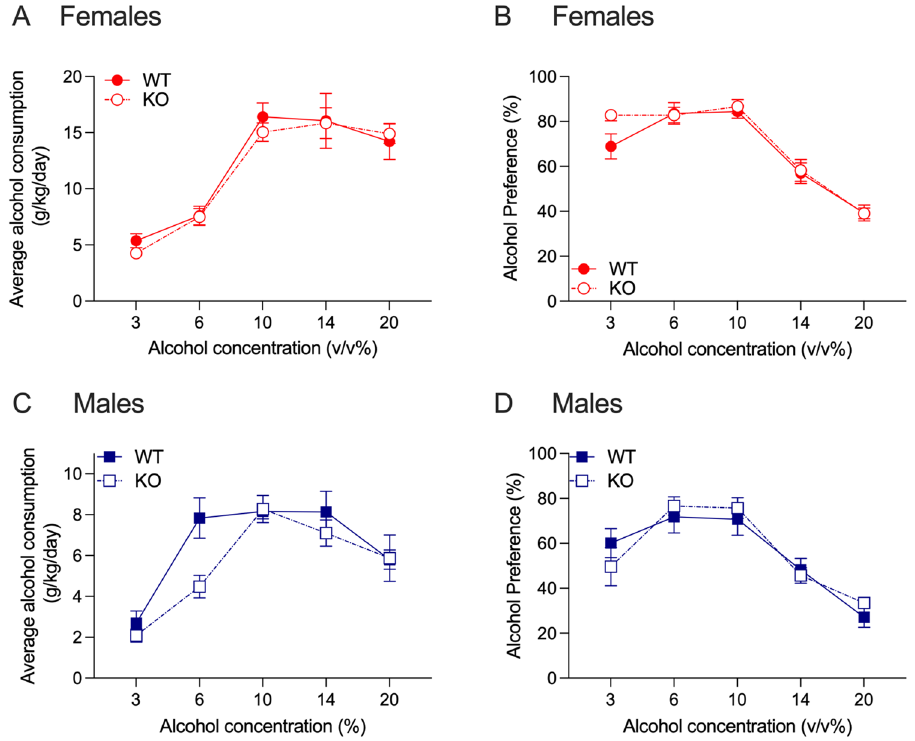
Figure 8. Alcohol consumption and preference in Grk4 WT and KO mice. No differences between female Grk4 WT and KO mice were observed for ( A ) alcohol consumption or ( B ) alcohol preference. No genotype differences were observed in ( C ) alcohol consumption or ( D ) alcohol preference between male Grk4 WT and KO mice. Data are presented as mean ± SEM, n = 10–11 female mice per genotype, n = 7–11 male mice per